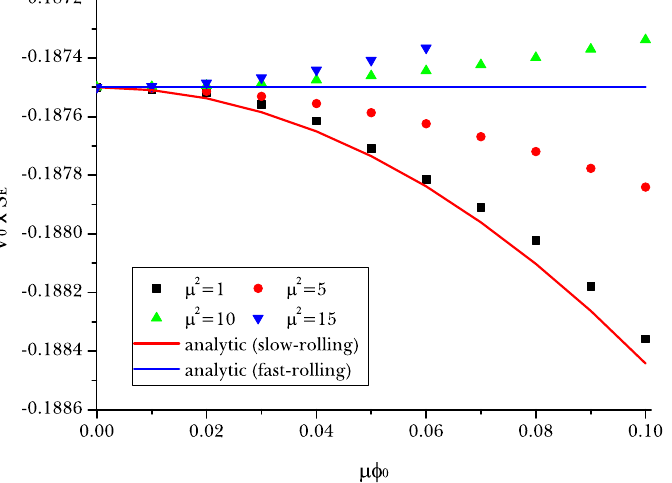
Figure 5. Euclidean action V 0 S E as a function of µφ 0 . The red curve is log P HHH ; however, the blue line is log P HSY